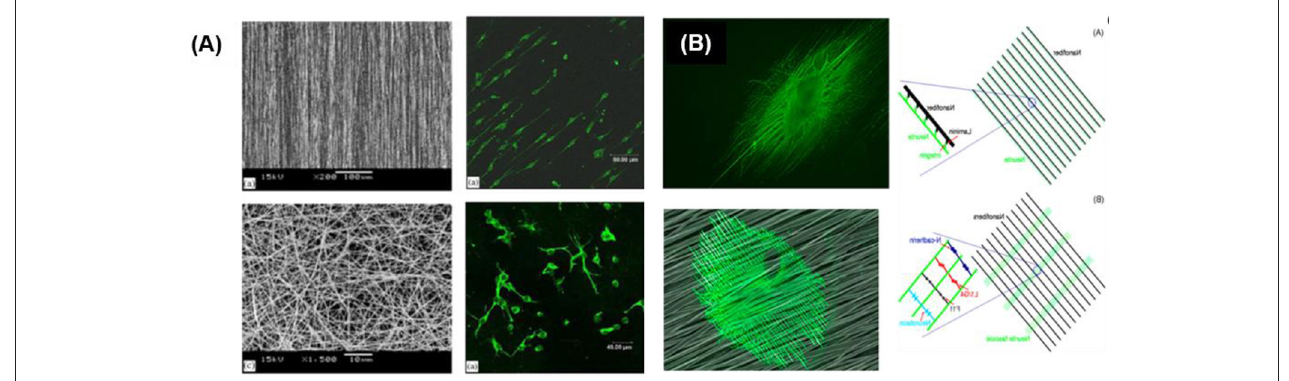
FIGURE 7 | Guided neurite extension on fibrillar networks (A) Neuron cells cultured on random and aligned fibers (Yang et al., 2005) Copyright 2005, Elsevier; (B) Neurites oriented along the nanofibers previously coated with laminin and perpendicularly to the nanofibers without adhesive coating (Xie et al., 2014) Copyright 2014, American Chemical